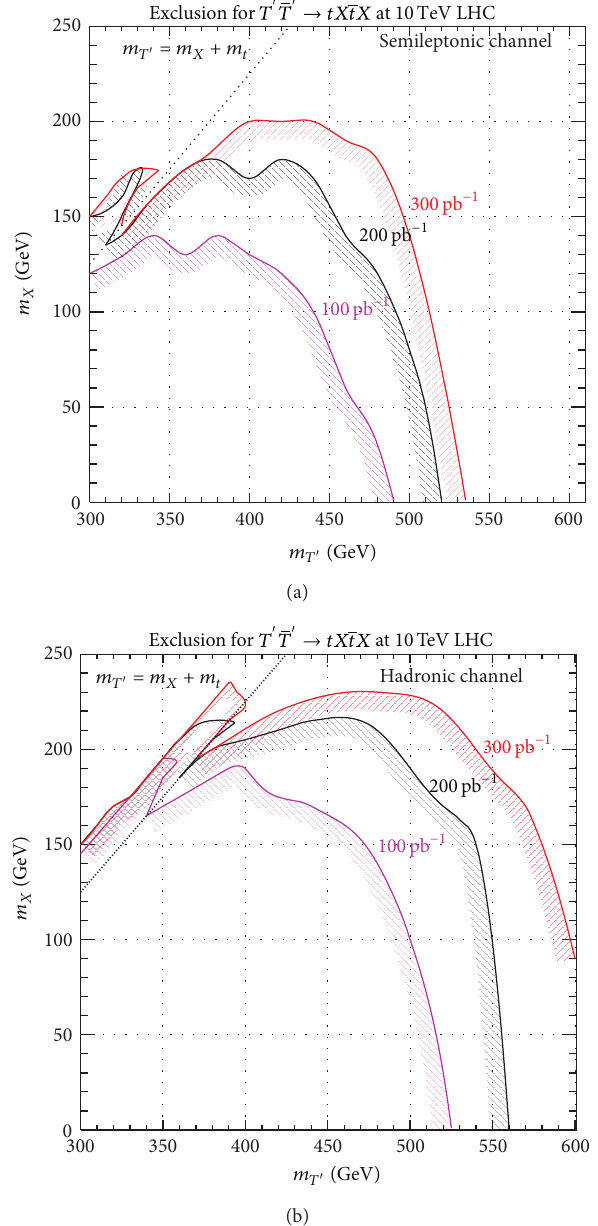
Figure 9: 95% CL exclusion contours for a 10TeV LHC run in the semileptonic (a) and the all-hadronic (b) search channels, for inte- grated luminosities of 100, 200, and 300 fb −1 (roughly comparable to 0.3, 0.6 and 1fb −1 at the 7TeV LHC). Figure from [36].